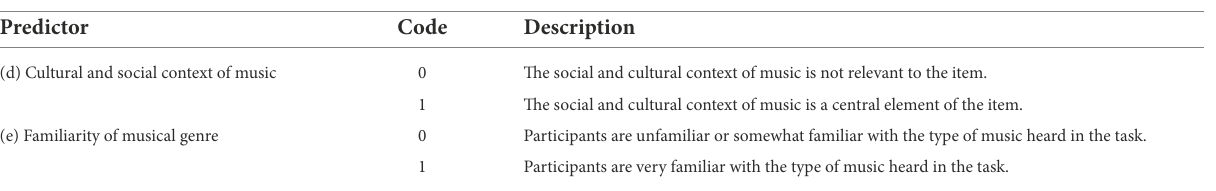
TABLE 4 Domain 2 of the identified item characteristics (predictors classified as